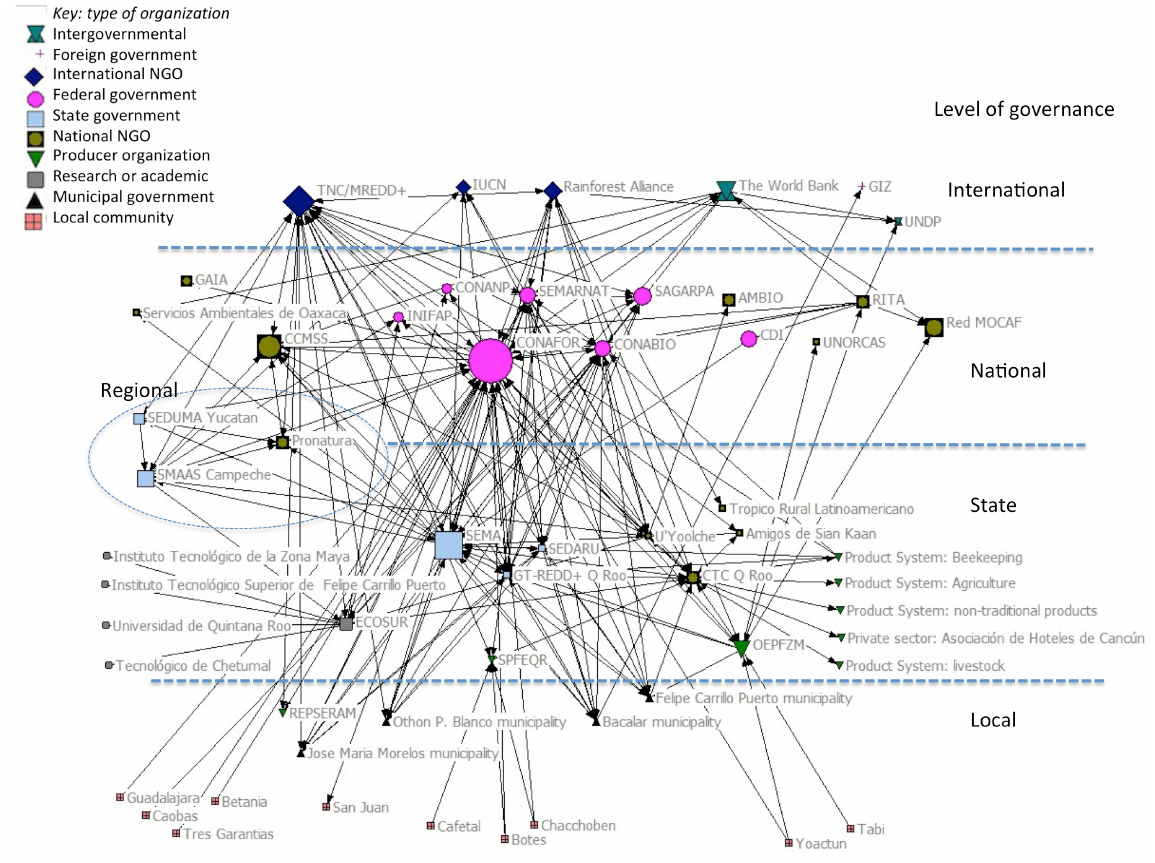
Figure 1. Cross-scale network of REDD+ information sharing. The ties represent relations in REDD+ information sharing. The direction of a tie (arrow) indicates direction of nomination; not all nominations were reciprocated. The perceived influence (normalized indegree centrality measure) of an actor is presented as the size of the node: the larger the node, the more influential the